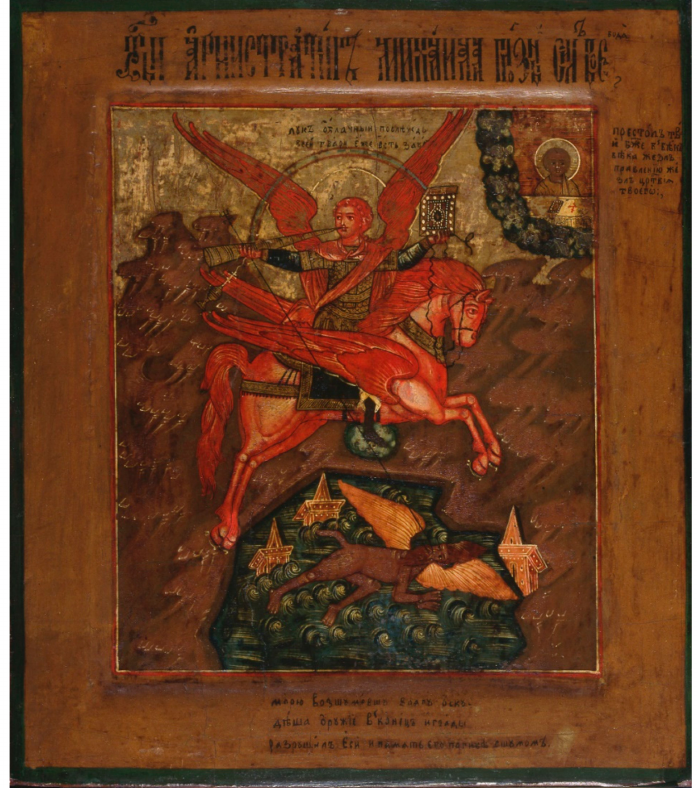
Figure 8. Archangel Michael, Archistrategos of Heavenly Hosts, Northern Russia, workshop of priestless Old Believers, beginning of 18th c., tempera on wood, 42.5 × 37, National Museum in Warsaw, photo: National Museum in